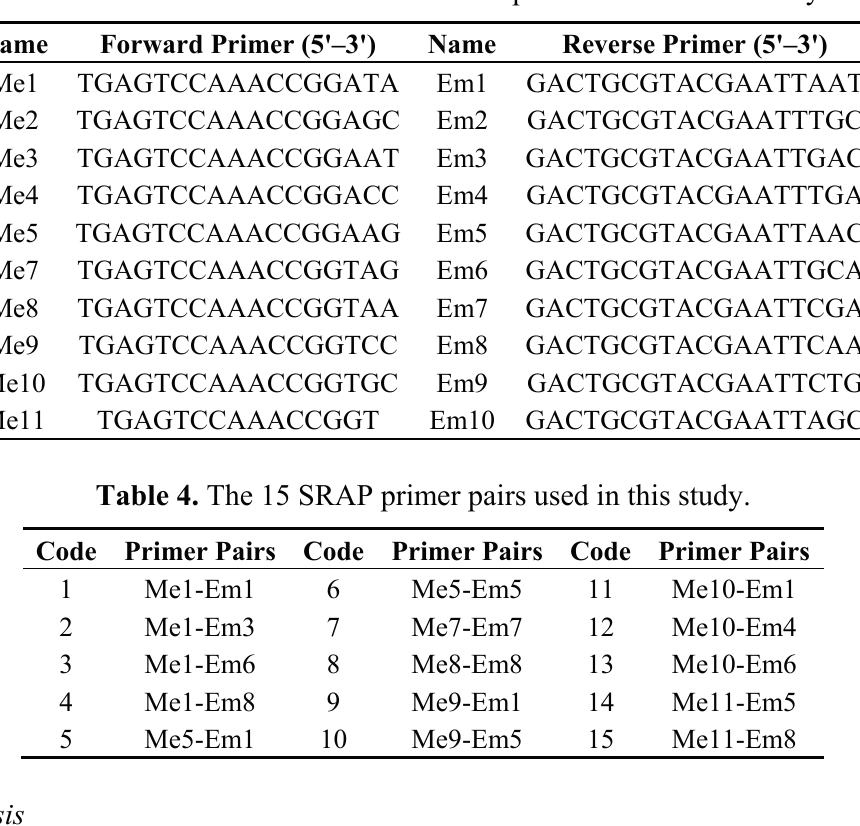
Table 3. The forward and reverse SRAP primers used in this study.